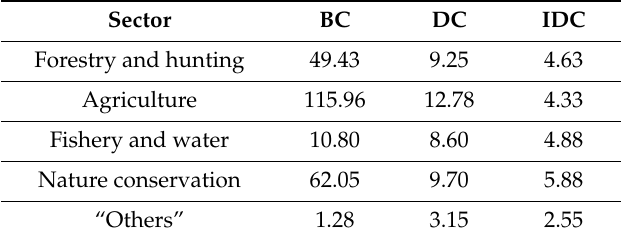
Table 2. Basic centrality values of the cooperation network by sectors.